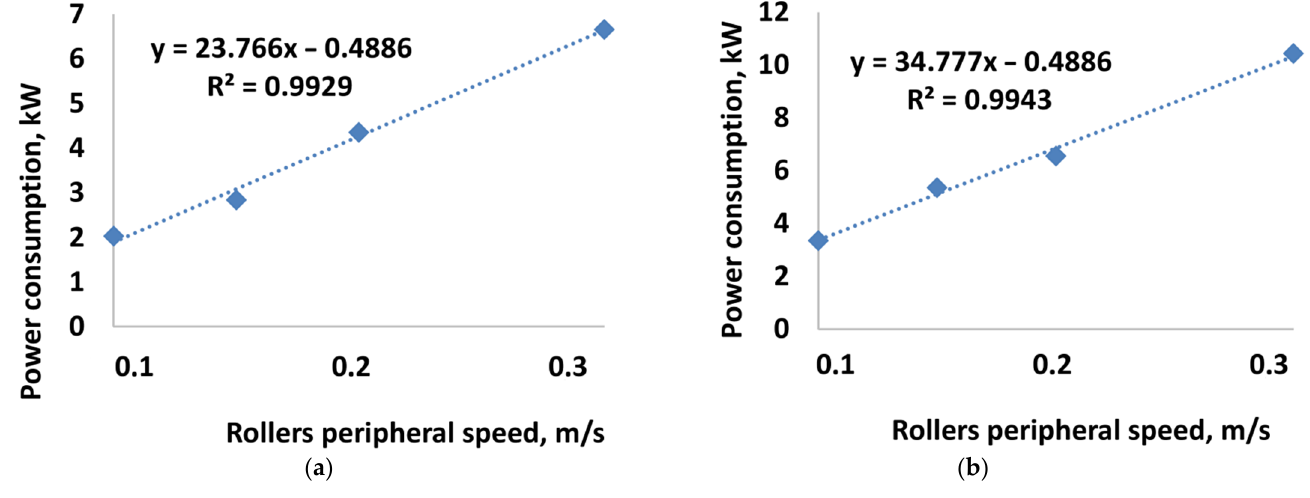
Figure 8. The dependence of power consumption on the peripheral speed of the rollers when briquetting: ( a )—calcium hydroxide; ( b )—mixture based on copper ore concentrate. Table 4. The dependence of the average density of briquettes on the peripheral speed of the rollers.